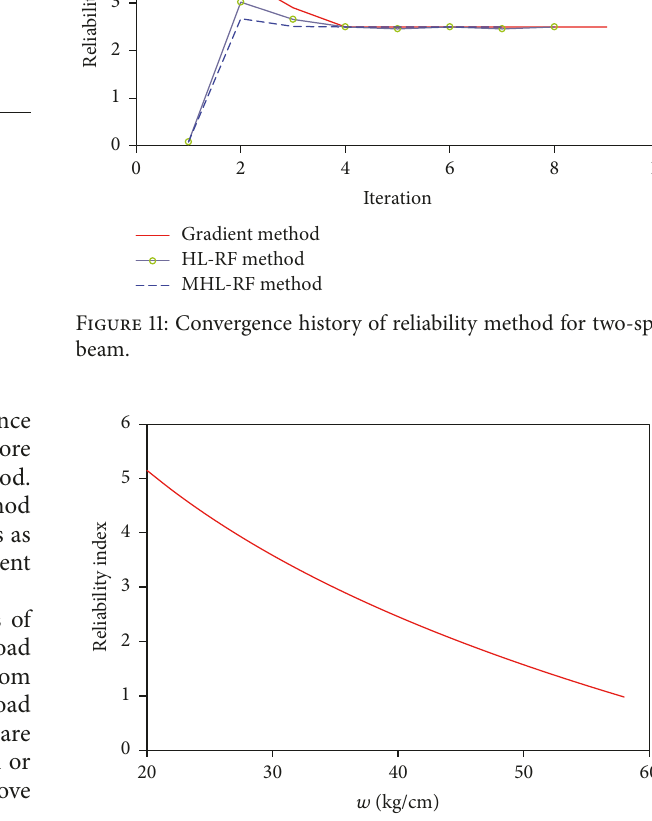
Figure 12: Reliability index with respect to the load for two-span beam